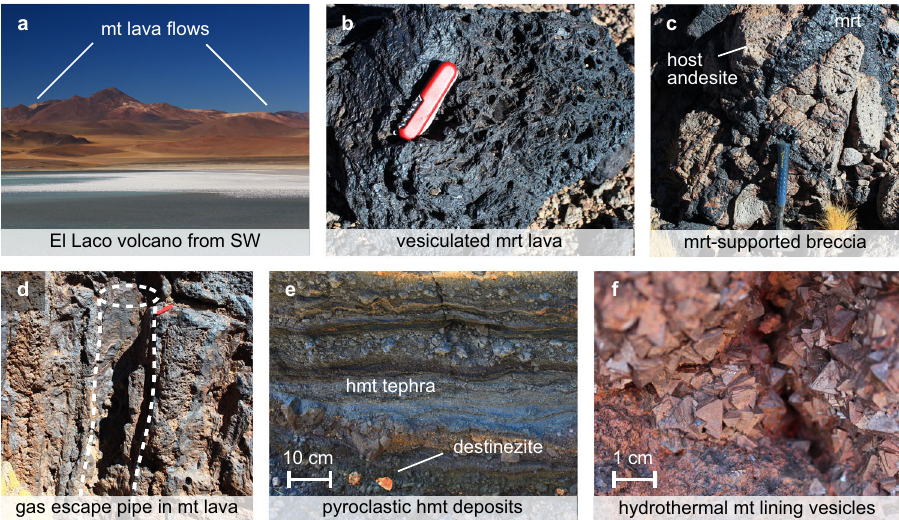
Fig.2|Examplesof fi eldevidenceforextrusiveoreformation.a ElLacovolcano withmagnetite(mt)lava fl owsseenfromSW; b vesiculatedmartite(mrt,haematite pseudomorphaftermt)lava; c volcanicbrecciawithveinssupportingfragmentsof